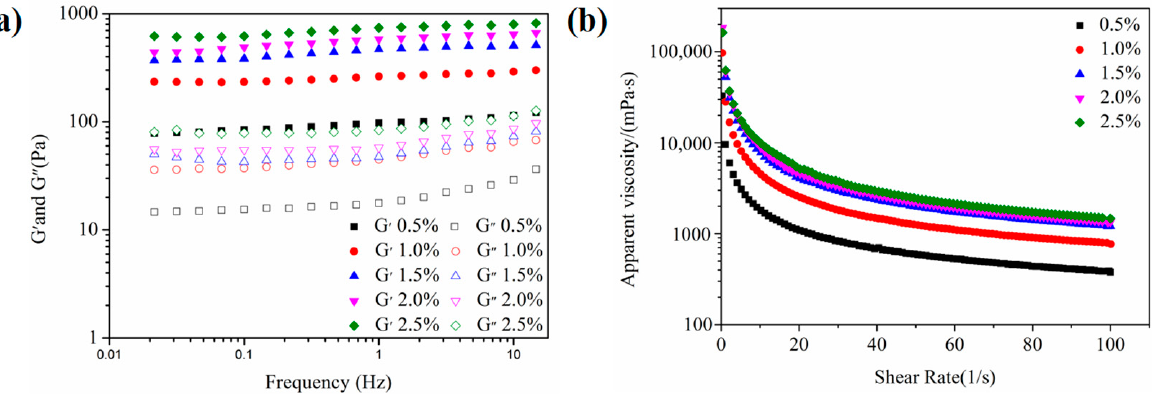
Figure 5. CLSM images (dilute the sample 10 times) of W 1 /O/W 2 emulgels (W 1 /O primary emulsion, 10%) stabilized by SSP concentrations were 0.5 wt%, 1.0 wt%, 1.5 wt%, 2.0 wt% and 2.5 wt%, respec- tively. The oil phase and outer aqueous phase were dyed with the Nile red and FITC, respectively. Scale bars, 50 μ m.